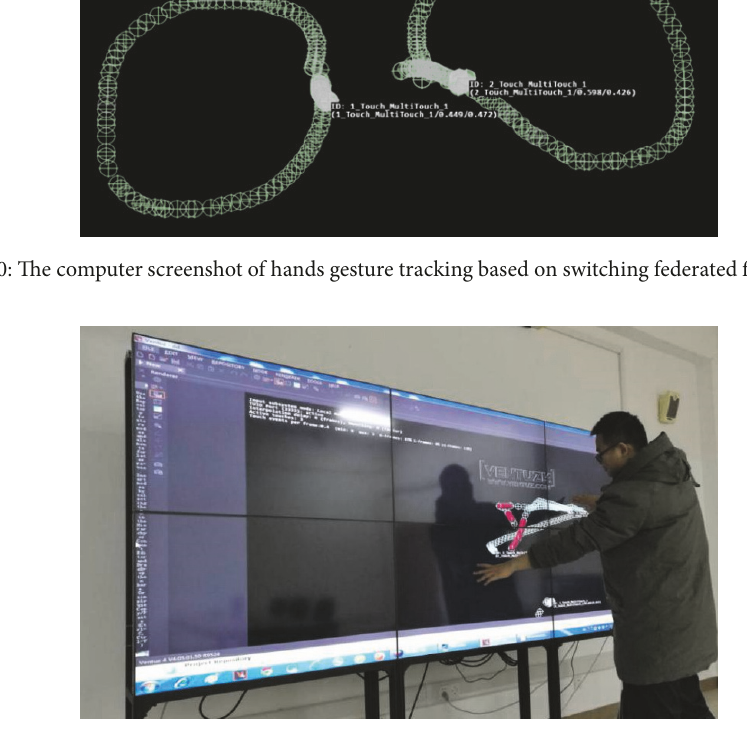
Figure 11: The hands gesture tracking effect based on Cam-shift algorithm.